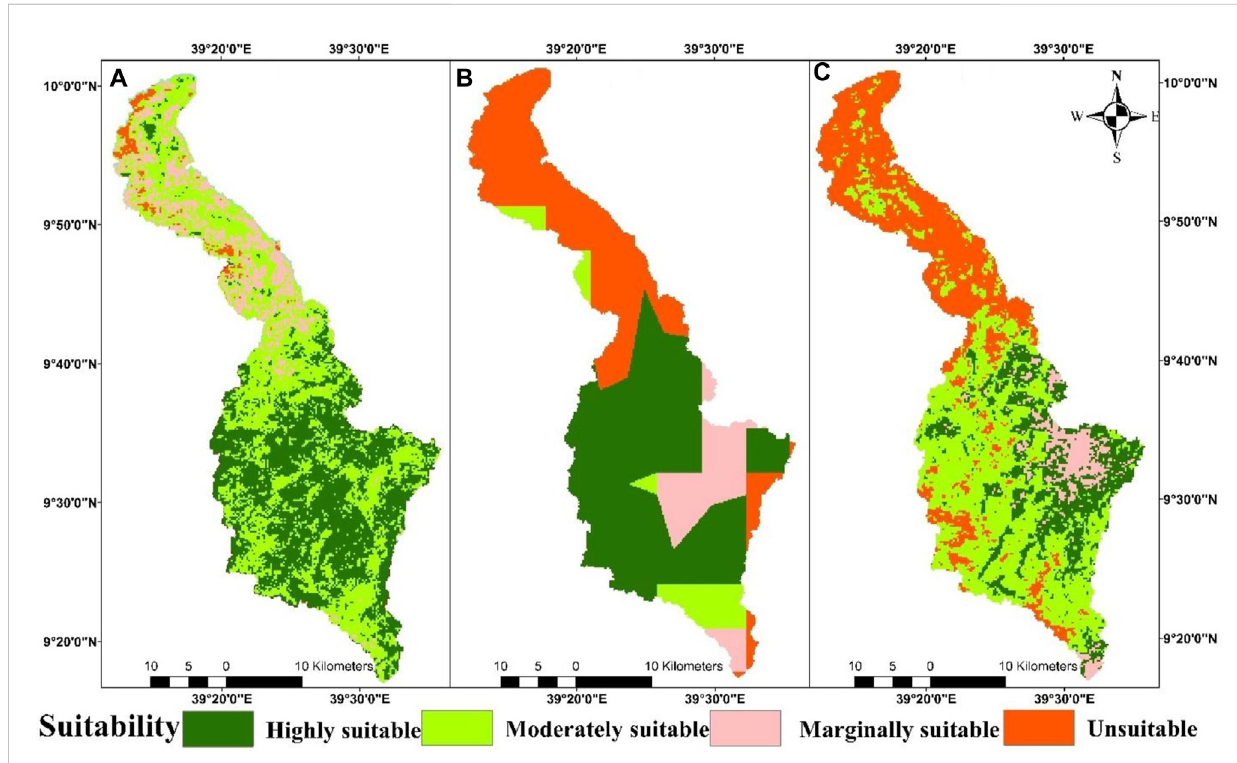
FIGURE 7 Surfaceirrigationsuitabilitydeterminedbasedonvariousfactors,including: (A) Cationexchangecapacity(CEC); (B) Availablewaterstoragecapacity (AWSC; and (C) Organic